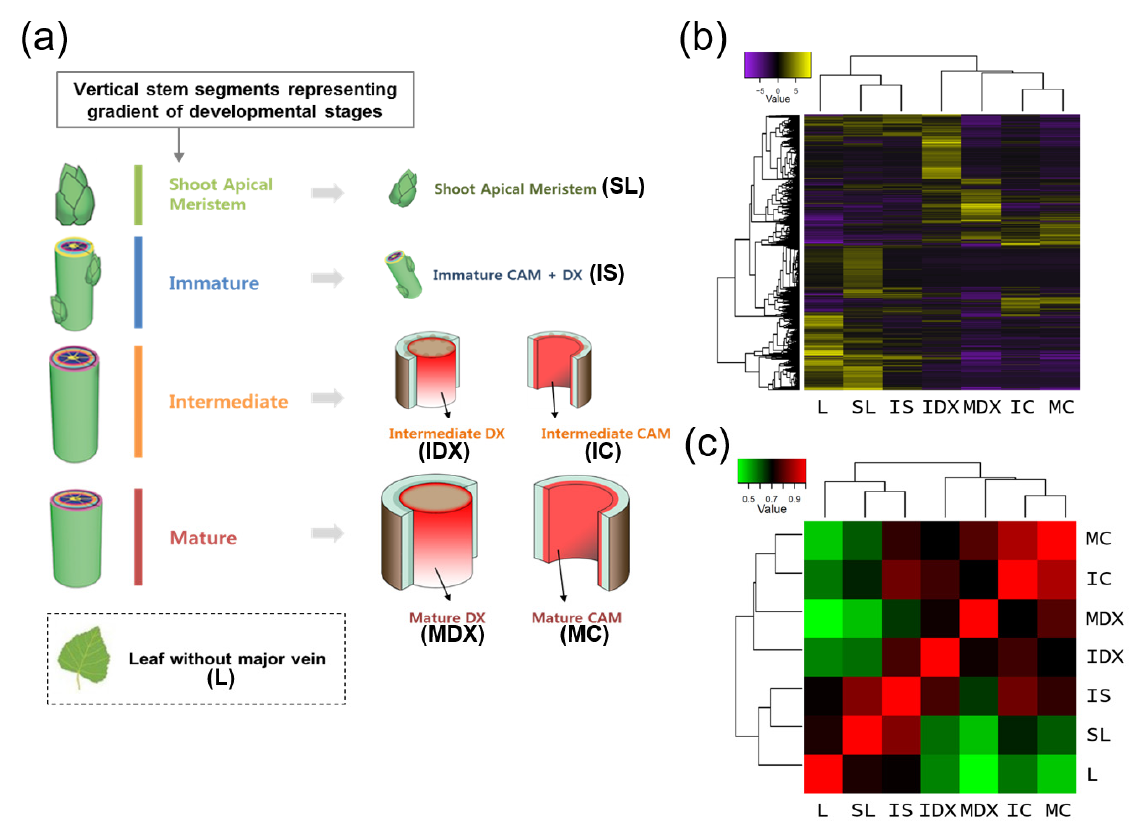
Figure 1. Tissue-specific transcriptome analysis of a hybrid poplar. RNA-seq analysis of various poplar tissues for tissue-specific study. ( a ) Strategy for poplar tissue sampling used in this study. Schematic diagram of tissue samples collected. SL (shoot apical meristem with leaf primordia), IS (immature stem), IC (intermediate cambium), IDX (intermediate developing xylem), MC (mature cambium), MDX (mature developing xylem), and ML (mature leaf without major veins). ( b , c ) Sample correlation by heatmap ( b ) and correlation matrix ( c ), which were produced by Trinity (analyze_di ff _expr.pl) with log2 fold change value ( p -value, 0.005).